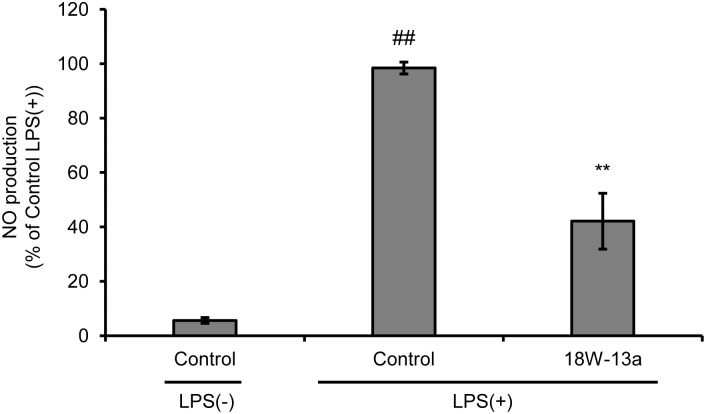
Effects of the AM18W-13a extract (18W-13a) on the LPS-induced production of NO in RAW264 cells. The cells were treated with the AM18W-13a extract at a concentration of 1/1000 for 24 h, while the cells in the control group were left untreated. Following treatment, the cells were activated by incubating with LPS (1 ng/ml) for 12 h. The quantity of NO produced was measured by the Griess reaction. The values represent the mean ± SD of results obtained from experiments performed in triplicate and are expressed as percentages relative to the results obtained from the control LPS (+) group. The mean value of the experimental result that significantly differed from that of the control LPS (–) group is indicated by ##p < 0.01. The mean value that is significantly different from that of the control LPS (+) group is indicated by asterisks (∗∗p < 0.01).